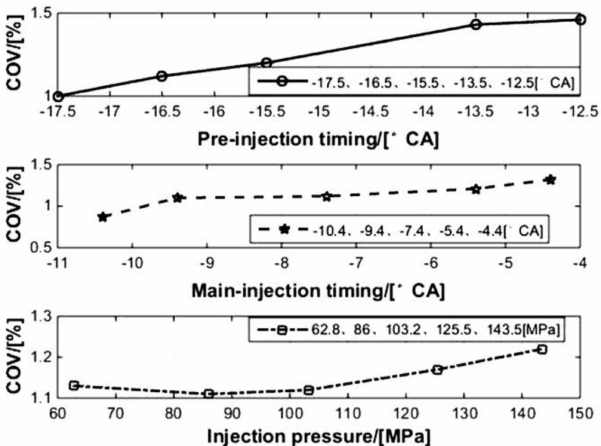
Figure 5. Effects of different injection parameters on the coefficient variation ( COV)